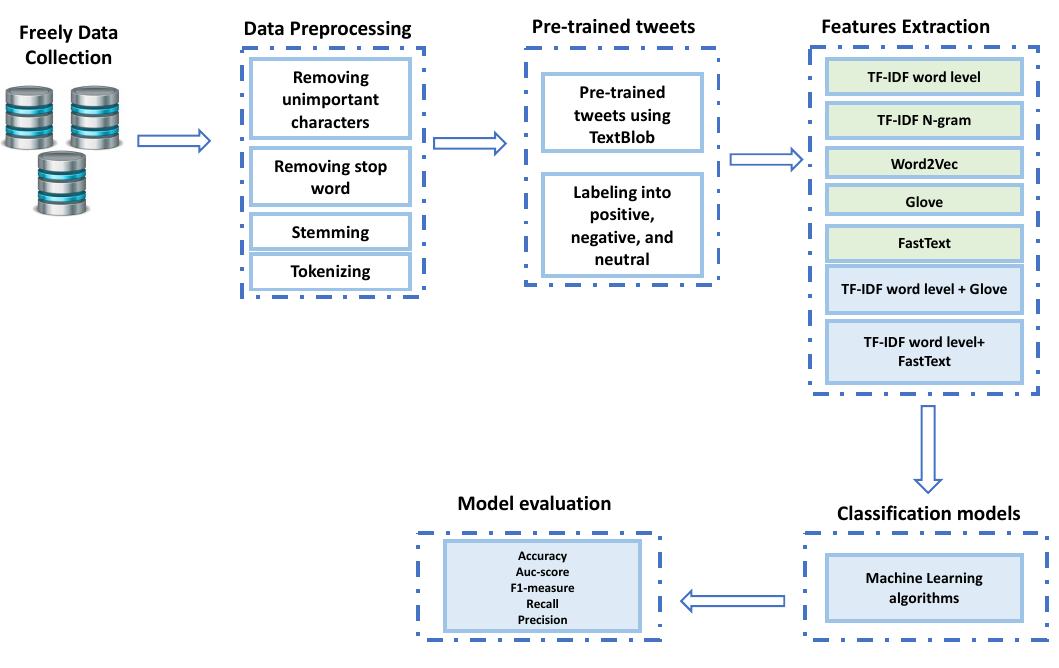
Figure 1. Framework of the proposed